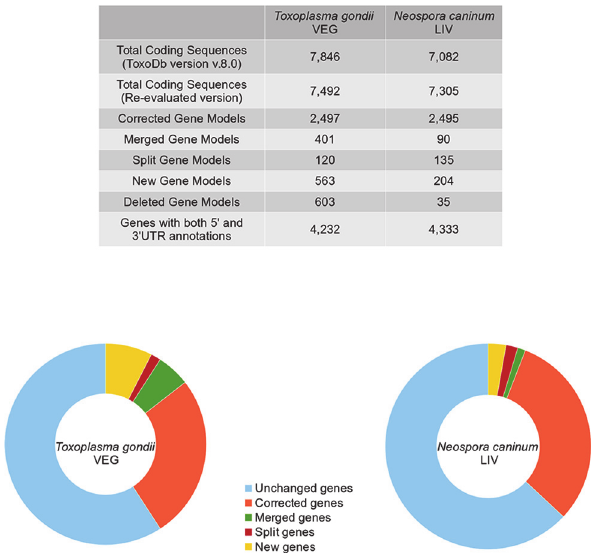
Fig 1. Summary of the manually curation of Tg VEG and Nc LIV (ToxoDb v8.0) genes. A gene model was “ corrected ” by adding/deleting exons or altering their exon-intron boundaries to conform to the transcript and peptide evidence. The corrected genes also include the models that were either “ split ” into two separate genes or “ merged ” into a single gene based on transcript splice-site evidence. “ New ” genes were annotated in open reading frames with clear expression evidence. Genes that lacked expression evidence and overlapped with an expressed gene model were considered spurious and “ deleted ” .